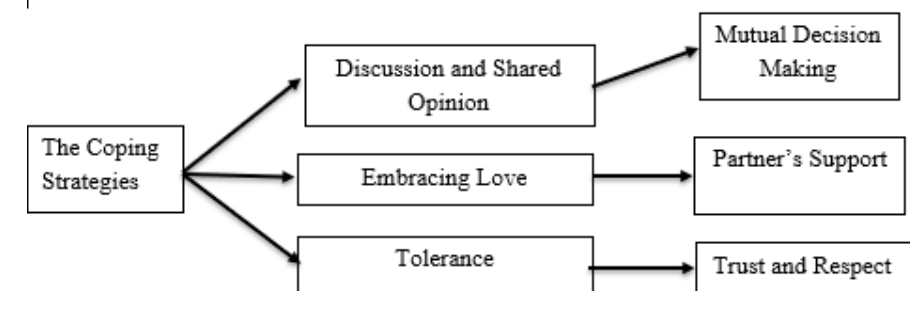
Figure 3 : The Coping Strategies